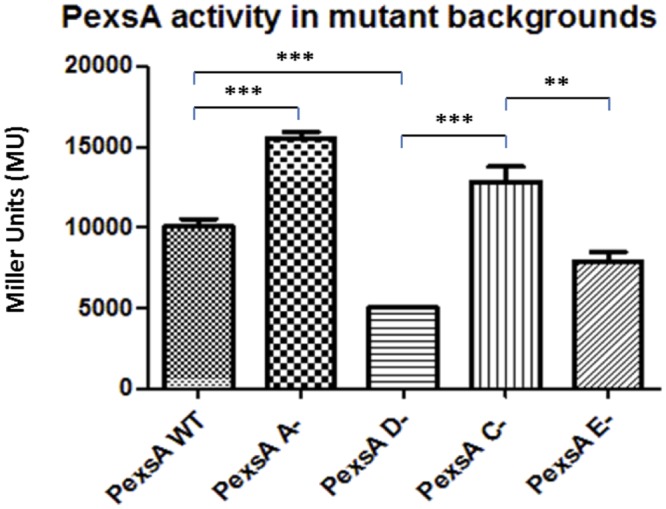
β-galactosidase activities of promoter PexsA in A. hydrophila AH3R wild type and mutant backgrounds. The promoter activity of PexsA demonstrated a significant increase in the exsA (A-) mutant and exsC (C-) mutant backgrounds when compared to the promoter activities measured in the exsD (D-) mutant and exsE (E-) mutant backgrounds (p < 0.01). Assays were carried out in triplicate and the values are the means. The error bars showed Standard Error of the Mean (SEM). The significance was determined by Student’s t-test (∗∗p < 0.01, ∗∗∗p < 0.001).